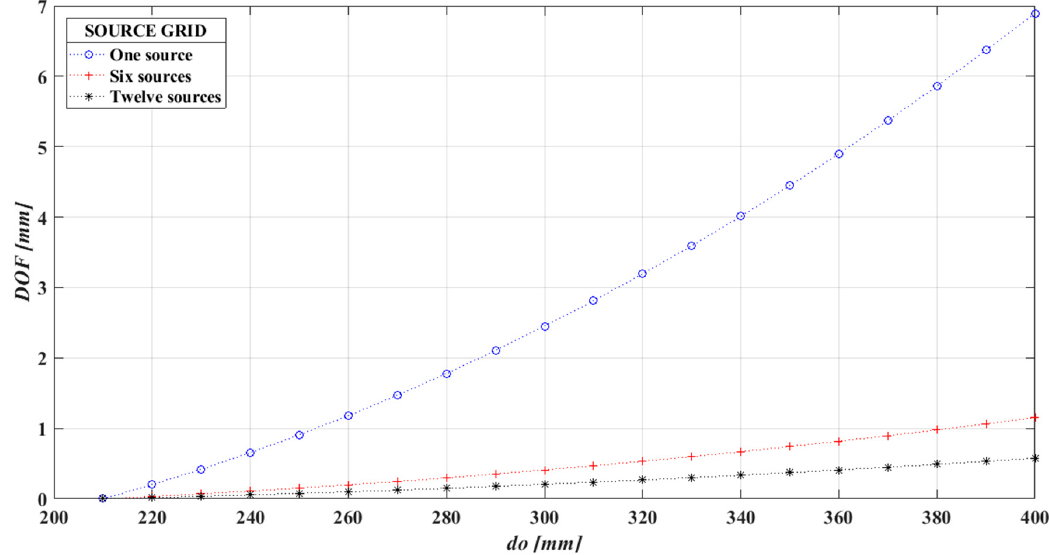
Figure 2. Theoretical performance of the focusing schlieren system used in this work.